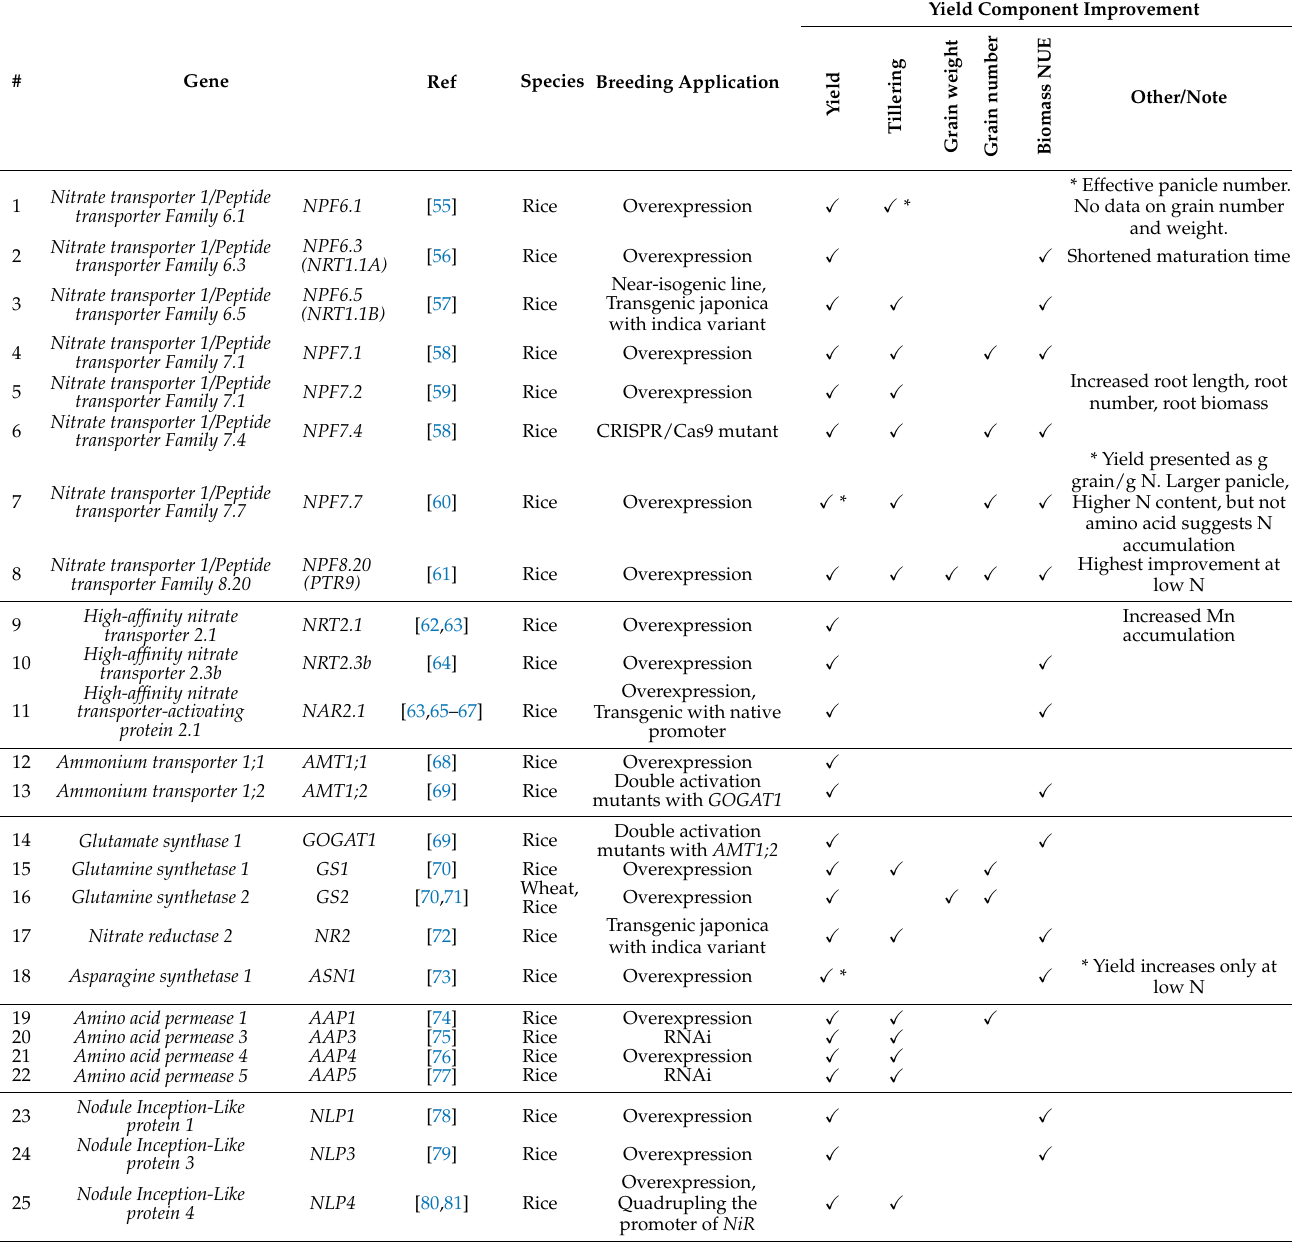
Table 2. Breeding applications of nitrogen metabolism genes in rice and wheat that were proven successful in improving